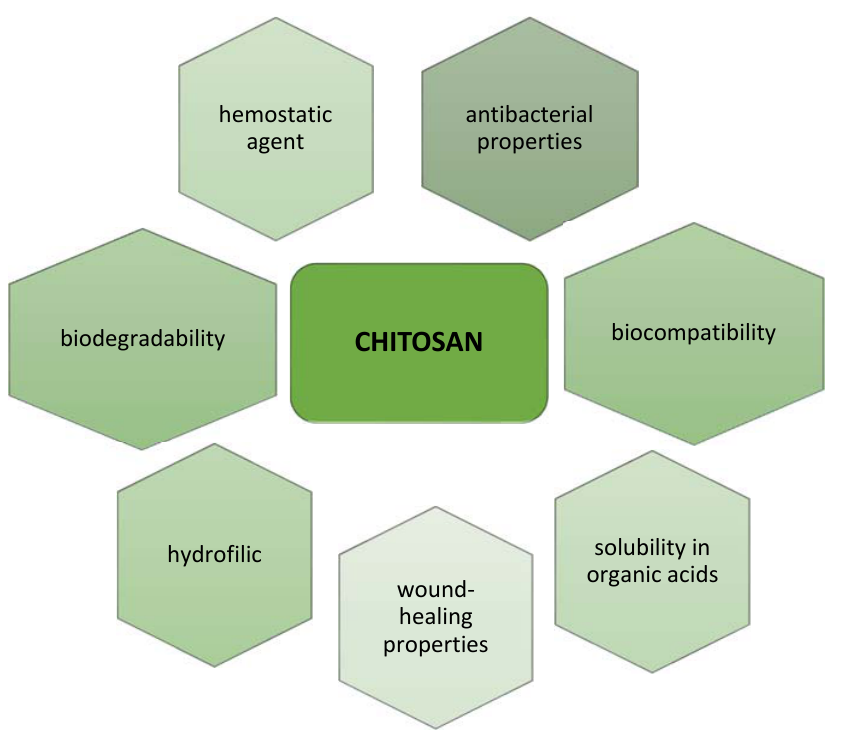
Figure 2. Chitosan properties.